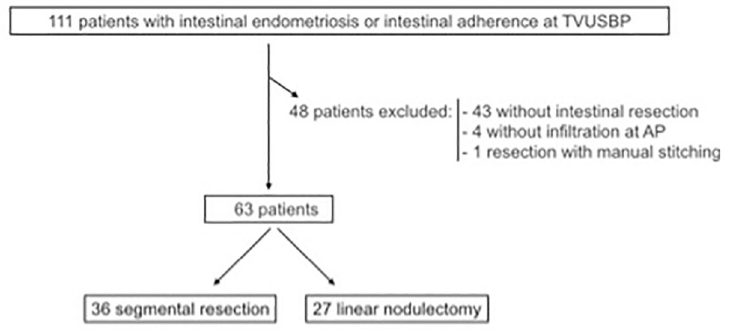
Fig 1. Flowchart of patient selection for the